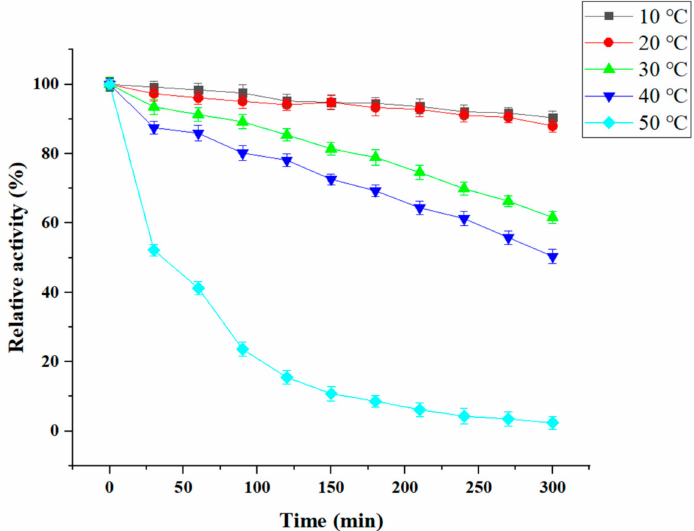
Figure 7. Temperature stability of CDA. The initial enzyme activity was set to 100%.